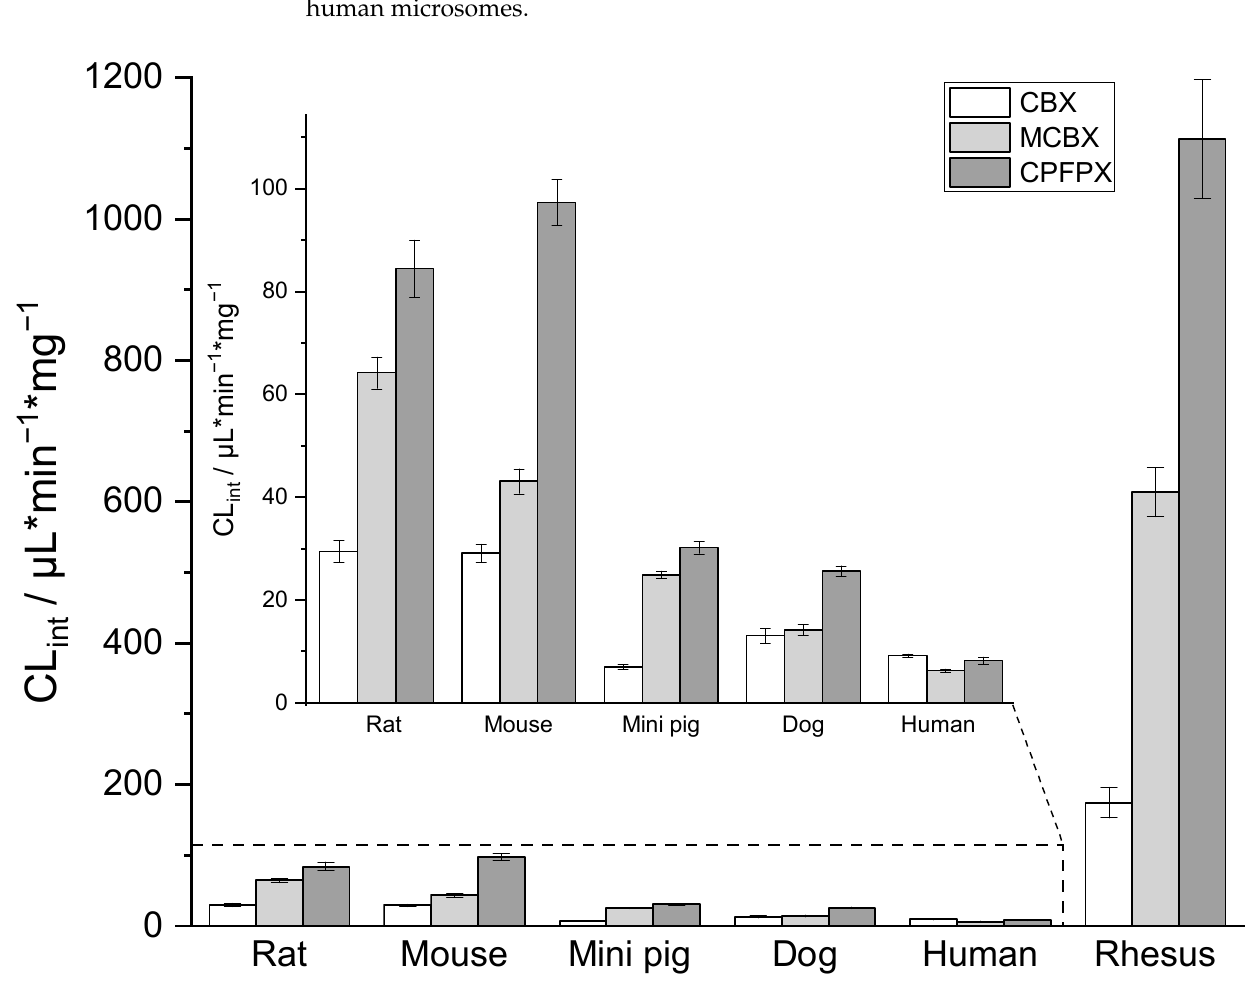
Figure 1. Comparison of CBX, MCBX, and CPFPX intrinsic clearance in liver microsomes from various species. Data represent the mean ± SD of four independent experiments.